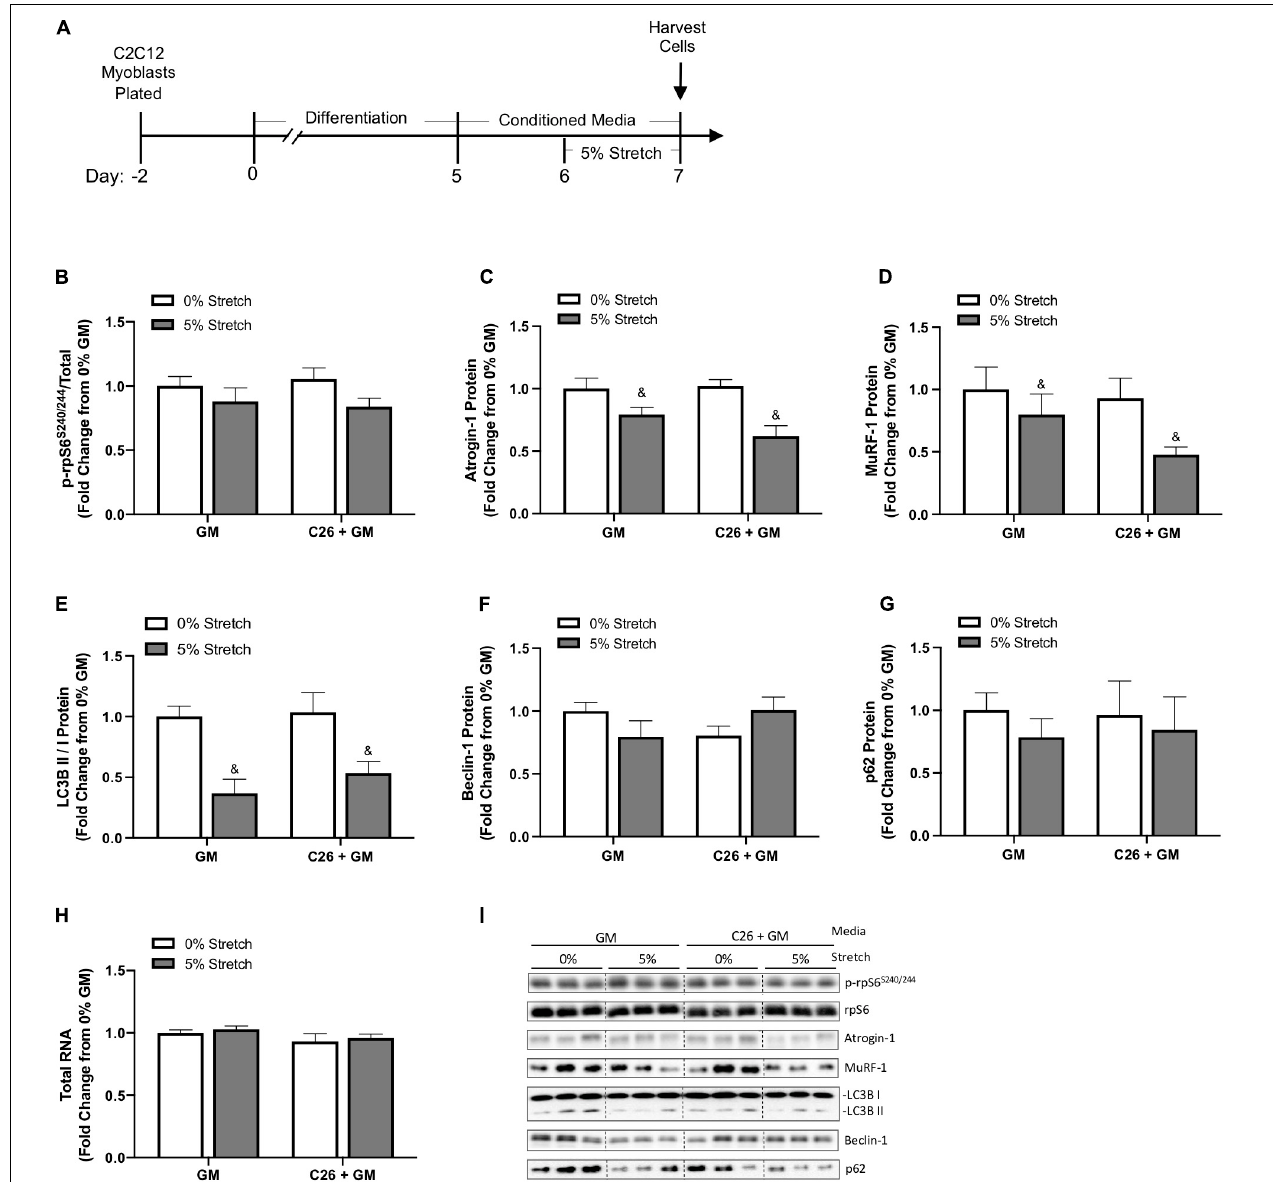
FIGURE 4 | Effects of 24-h stretch on growth related signaling in myotubes treated with colon-26 (C26) tumor-derived factors. (A) Experiment overview: C2C12 myoblasts are plated on Uniflex membranes in growth media (GM); after 48 h at ∼ 85% confluence, differentiation media is added, which corresponds to day 0. Myotubes are differentiated for 5 days upon which 50% conditioned media (CM; GM or C26 + GM) is diluted with serum-free DMEM and added to wells for 48 h; myotubes are either left unstretched (0%) or stretched 5% in the last 24 h of CM incubation. Western blotting analyses of (B) ratio of phosphorylated (p-) to total protein expression of ribosomal protein S6 (rpS6 S 240 / 244 ) ( n = 6/group), (C) Atrogin-1/muscle atrophy F-box (MAFbx) ( n = 6/group), (D) Muscle RING finger 1 (MuRF-1) ( n = 6/group), (E) microtubule-associated protein light chain 3B (LC3B) II/I ratio ( n = 6–12/group), (F) Beclin-1 ( n = 6/group), and (G) p62/SQSTM1 ( n = 6/group) protein expression. (H) Total RNA content ( n = 6/group). (I) Representative Western blotting images; dashed line represents different areas of the same gel. Data are presented as means ± SEM as a fold change from GM 0% stretch. Two-way ANOVAs were performed to determine differences. & Main effect of stretch. Statistical significance set at p ≤